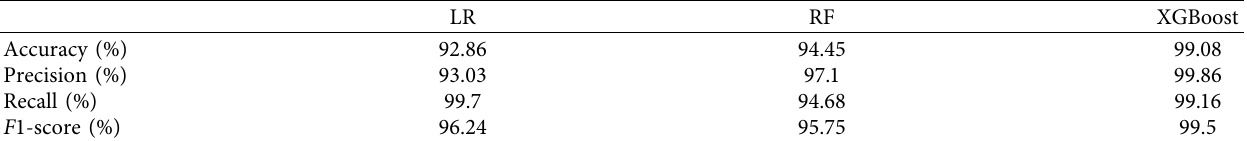
Figure 7: XGBoost confusion matrix. Table 5: Classifcation models by handling imbalanced